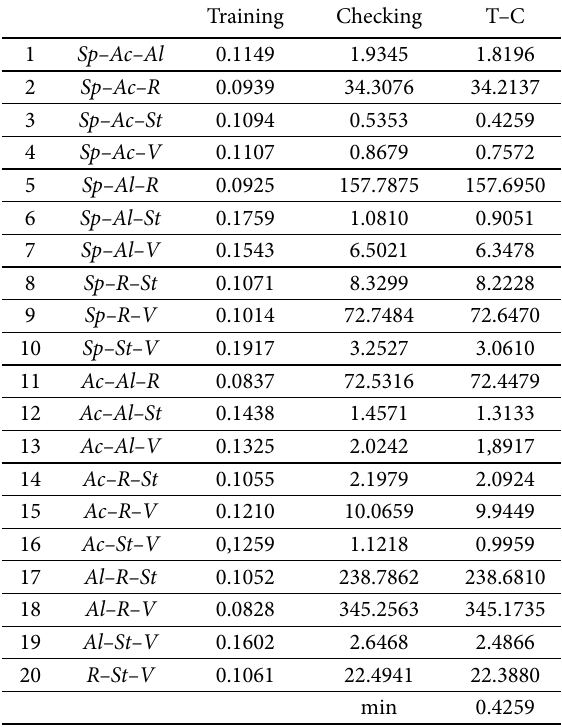
Table 3. Training and checking errors with three inputs at a